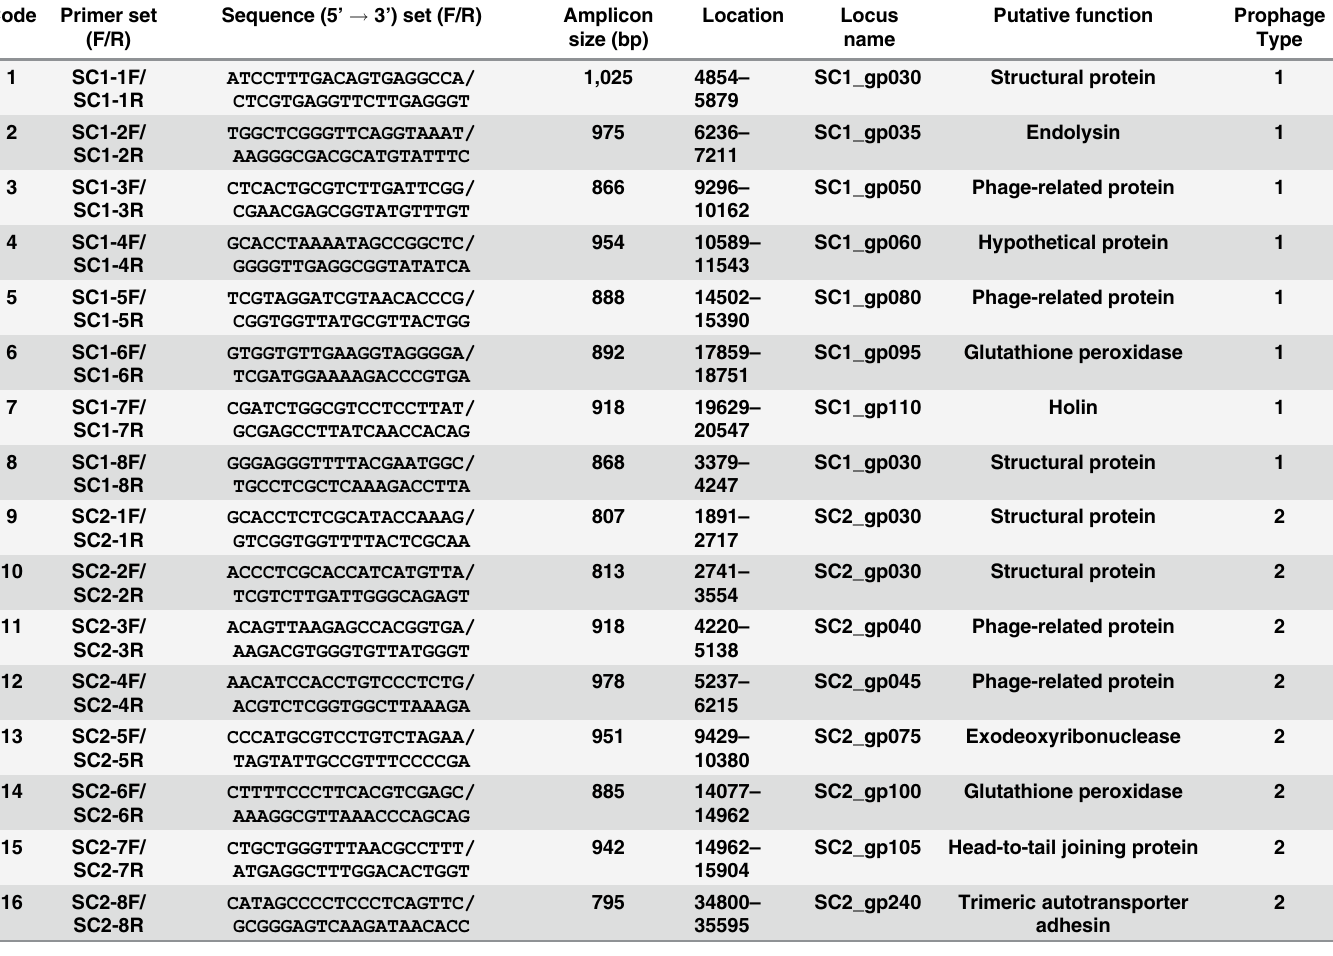
Table 2. General information of primers specific to Type 1 or Type 2 prophage of “ Candidatus Liberibacter asiaticus ” based on comparisons of prophage sequences between SC1 and SC2. Code Primer set